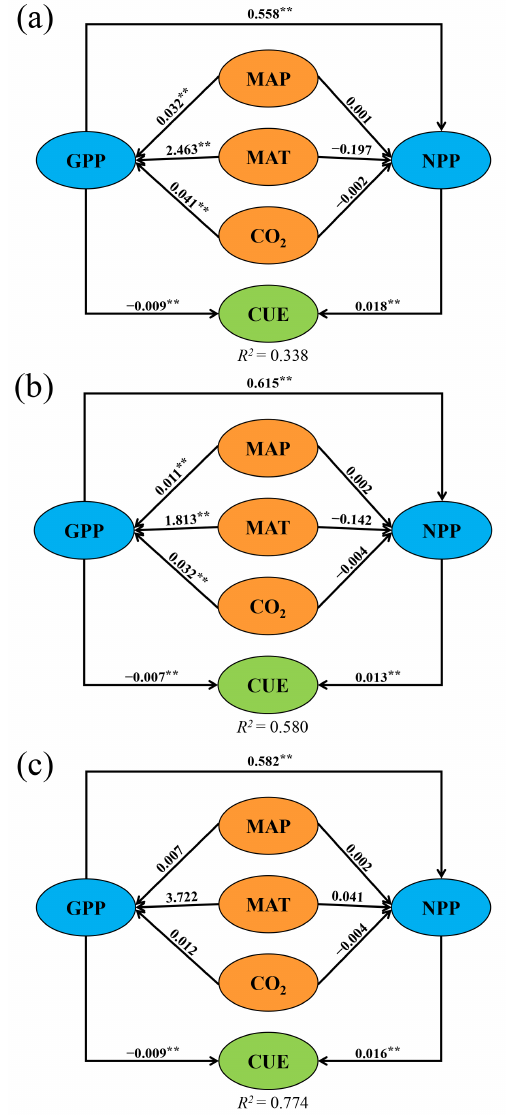
Figure 4. Structural Equation Model (SEM) of CUE and environmental variable factors under three future climate scenarios. SEM images under the SSP1-2.6 scenario are shown in ( a ). SEM images under the SSP3-7.0 scenario are shown in ( b ). SEM images under the SSP5-8.5 scenario are shown in ( c ). The straight line is the linear relationship between potential variables of the structural equation and observed variables, and standardized path coefficients are shown on the relevant path. ** represents the very significant level of the direct path